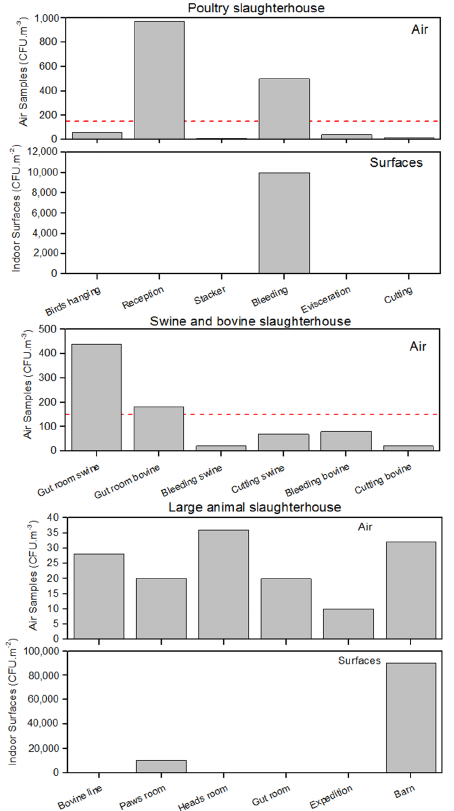
Figure 1. Fungal load distribution in the three assessed slaughterhouses. The dashed line represents the reference limits suggested by the World Health Organization (WHO).